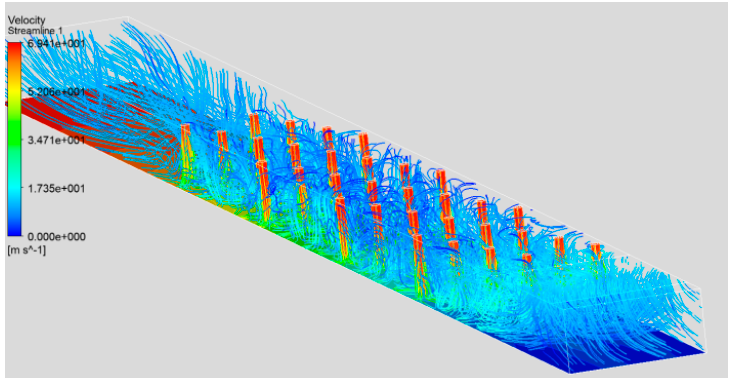
Figure 16. Streamlines in jet cooler model.